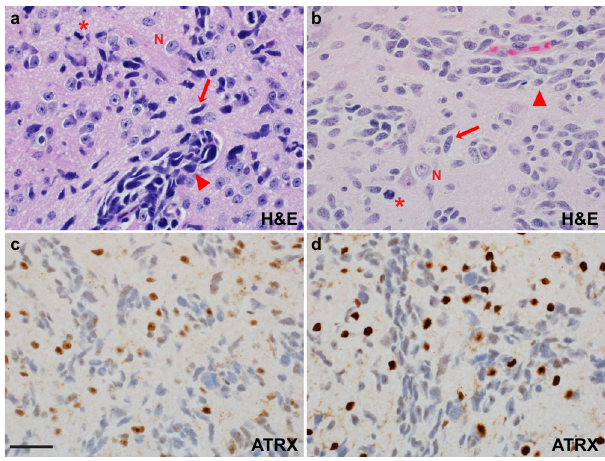
Fig. 3 Histopathology of PDOX recapitulates salient features of the patient tumor from which it was derived. H&E staining of HGG PDOX SJ- HGGX6 ( a ), shown as a representative example, recapitulates histologic features of its corresponding primary human tumor ( b ), including in fi ltration of the CNS parenchyma (arrow), perivascular invasion (black right pointing triangle), and apparent mitotic activity (asterik). Nuclear ATRX immunoreactivity, while retained in the entrapped neurons, is lost in the PDOX tumor cells ( c ), as in its corresponding primary human tumor ( d ). N: entrapped cerebral cortical neurons. Scale bar: 50 µ m. H&E staining was performed for 21 PDOX models, 20 with matching patient tumor. ATRX IHC was performed in six PDOX/patient tumor pairs, four with ATRX mutation, and two without ATRX mutation. Loss of ATRX immunoreactivity was consistent with mutation status in all samples